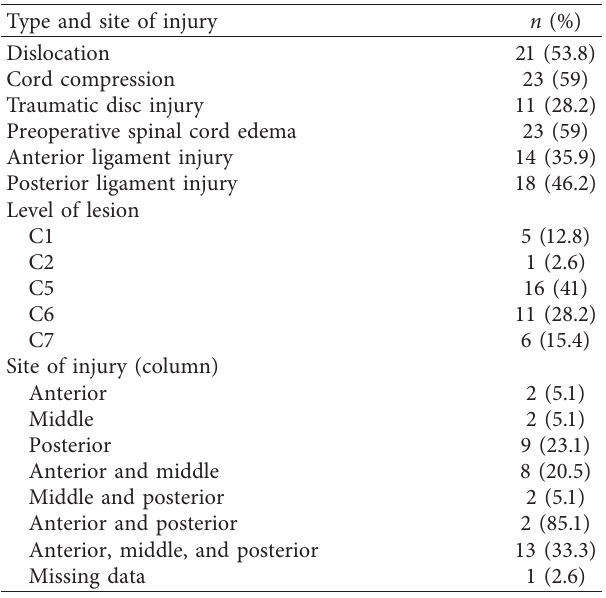
Table 3: The American Spine Injury Association (ASIA) impair- ment scale profiles in our series.